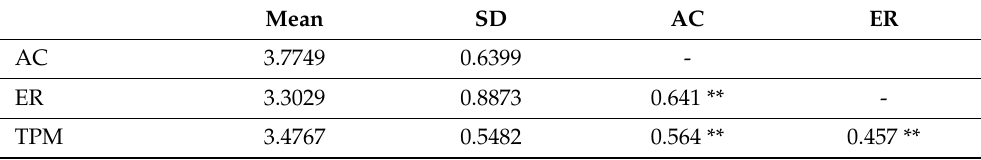
Table 2. Correlation.